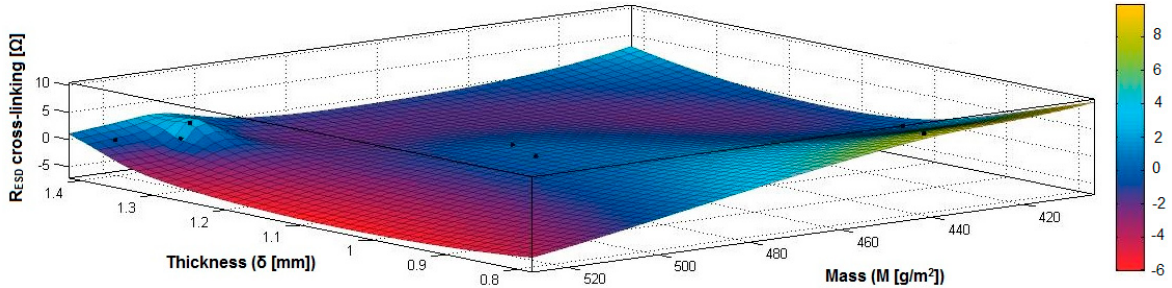
Figure 32. 3D representation R ESD after crosslinking = f(M, δ ) samples preliminarily treated in RF plasma O 2 using RF 2 generator and power 100 W.